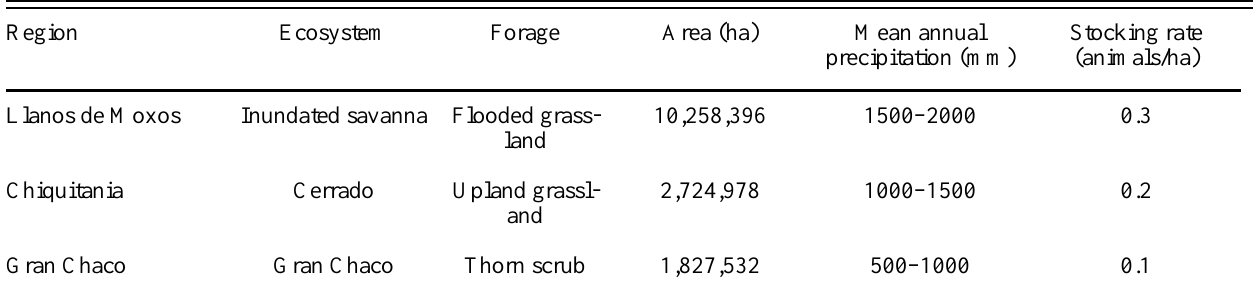
Table 4. Characteristics of extensive cattle ranches in three geographical regions of eastern Bolivia.